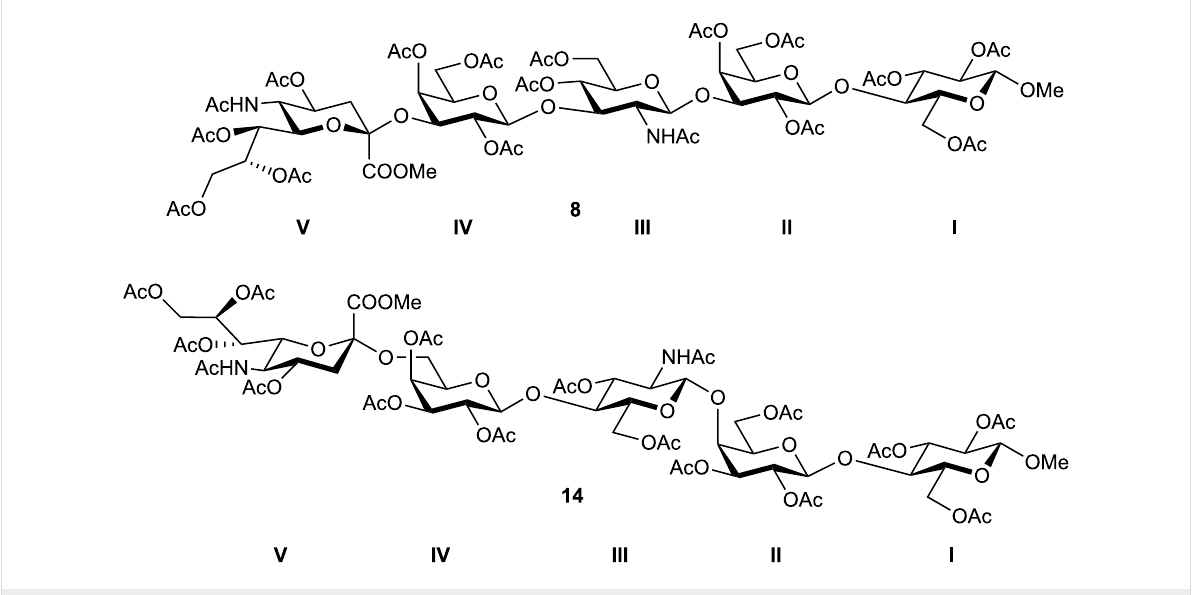
Figure 2: Roman numbering of saccharide units in all pentasaccharides for NMR assignment.